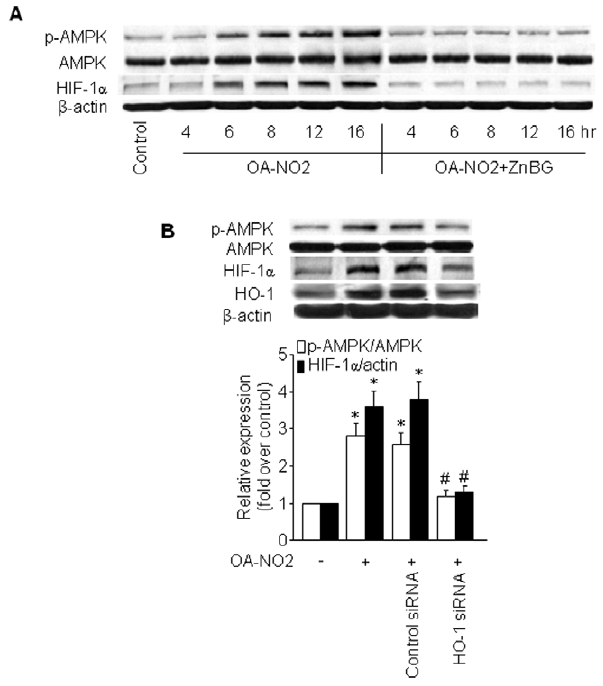
Figure 3. OA-NO 2 -induced HIF-1 a is dependent on HO-1. A ) HUVECs were treated with 1 m M ZnBG for 30 min followed by incubation with OA-NO 2 for the indicated times. AMPK protein and phosphorylation levels and HIF-1 a protein expression were assayed as described in Materials and Methods. The blot is representative of three blots obtained from three independent experiments. B ) HUVECs were incubated with HO-1-specific siRNA or control siRNA for 48 h and then treated with OA-NO 2 or vehicle for 16 h. After treatment, cell lysates were analyzed for HIF-1 a and HO-1 protein levels and AMPK phosphorylation at Thr172. Lower panels : summary data (* p , 0.05 vs. control; # p , 0.05 vs. OA-NO 2 group; n =3).